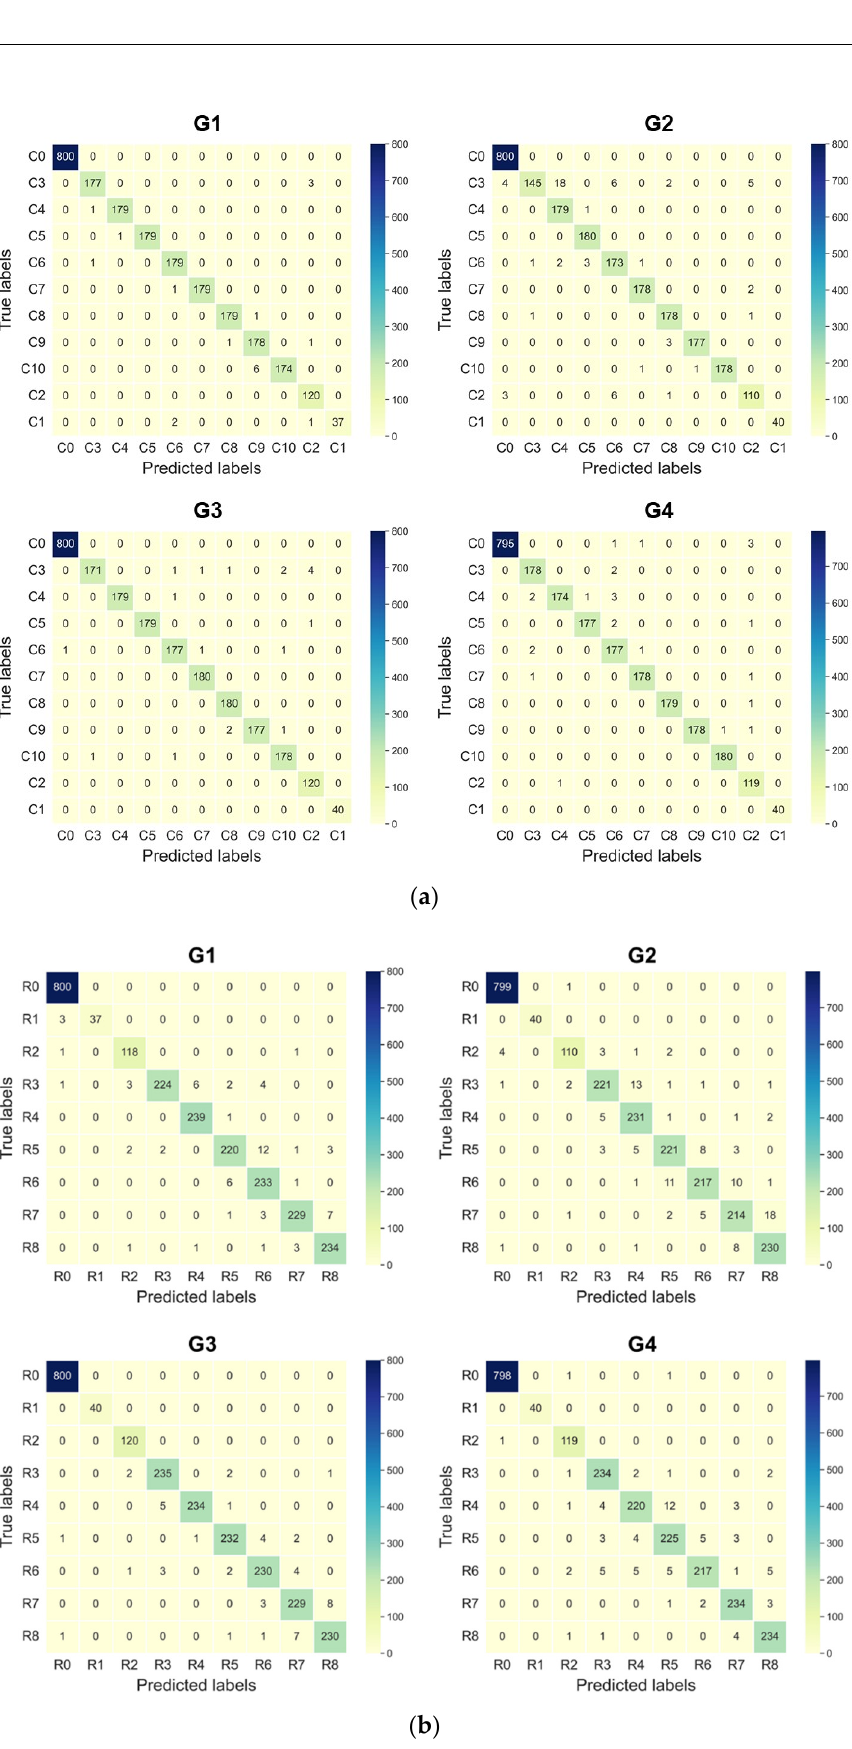
Figure 13. ( a ) Confusion matrices of different groups in Case 1; ( b ) confusion matrices of different groups in Case 2.